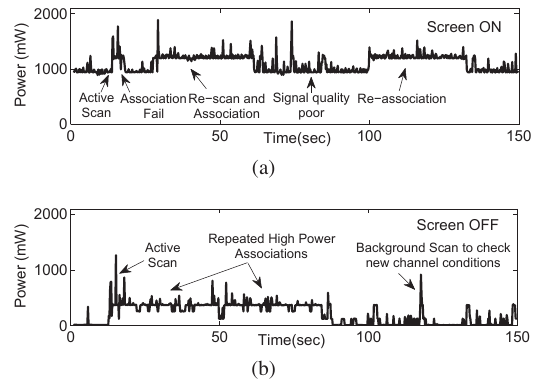
Figure 2: Repeated scan/association events under poor AP signal when the device screen is (a) ON, (b) OFF.